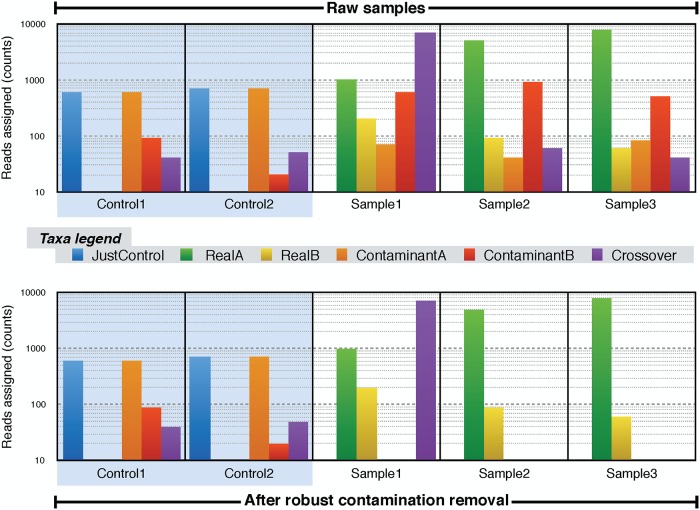
Robust contamination removal.This is a hypothetic example with 5 samples and 6 dominant taxa to illustrate how the algorithm works. The top and bottom part of the figure shows the absolute frequency of reads assigned to the taxa before and after the contamination removal, respectively. There are two control samples, not modified throughout the process. In the rest of specimens, the general contaminants (those taxa present in the controls and other samples, like ContaminantA and ContaminantB) are removed, except in case of crossover contamination: those taxa are kept in the source sample or samples (Sample1 here) and removed from other real samples (Sample2 and Sample3 in this example). The algorithm parameter ξ is set to 2.